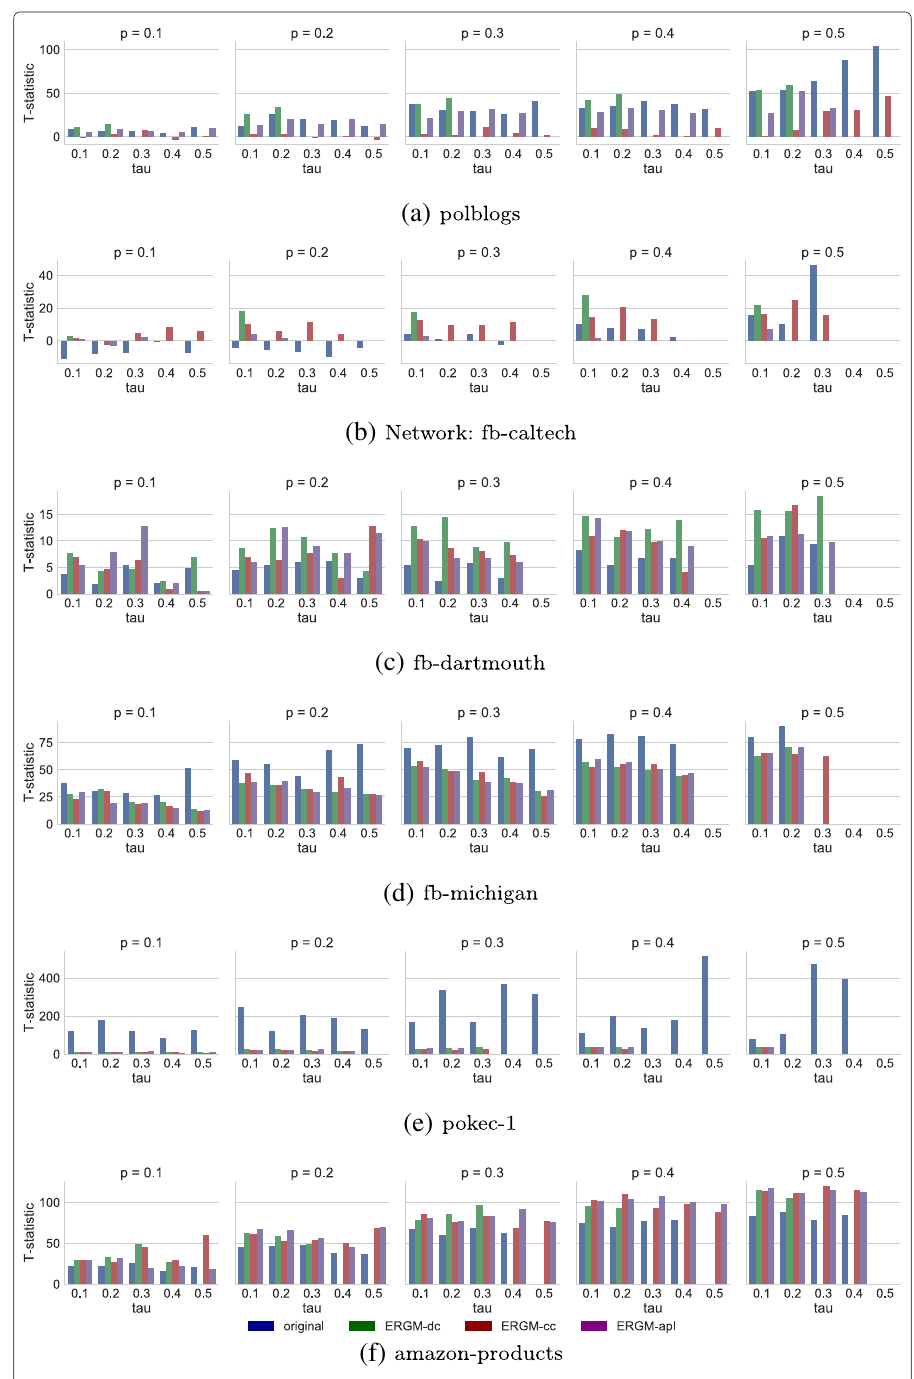
Fig. 5 Accuracy of predictions is presented using 5 × 2 cross-validation F1-scores. T-statistic between prediction scores of GS(LBL) and GS are shown. Results are shown across different structures of original and ERGM graphs. Each ERGM graph is presented using the generated parameters of dc (degree-correlation), cc (clustering coefficient) and apl (average path length). a polblogs b Network: fb-caltech c fb- dartmouth d fb-michigan e pokec-1 f